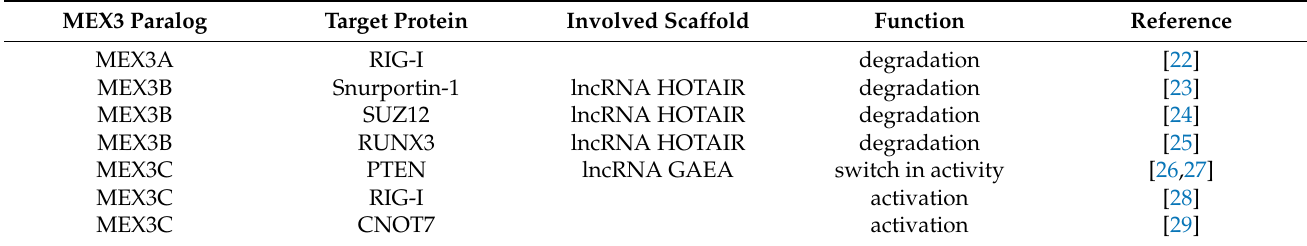
Table 2. Ubiquitination targets of MEX3